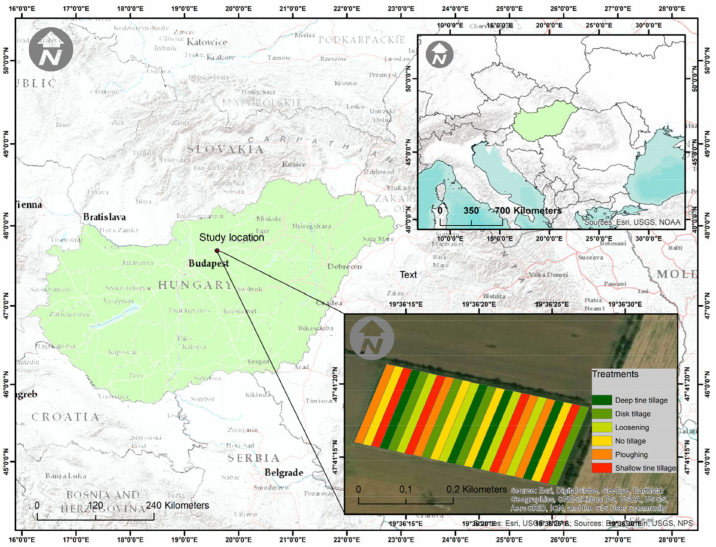
Figure 1. Location of experiment and treatments in Hungarian and Central European